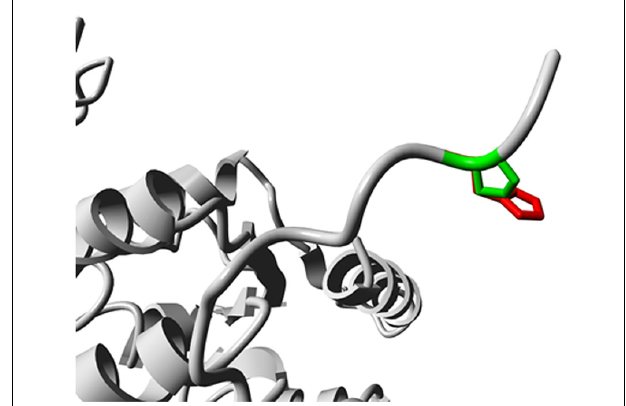
FIGURE 1 | Screenshot of the 3D homology model of theTLR2 protein using theYASARA software. The side chains of the wild-type and mutant residues are shown in green and red,